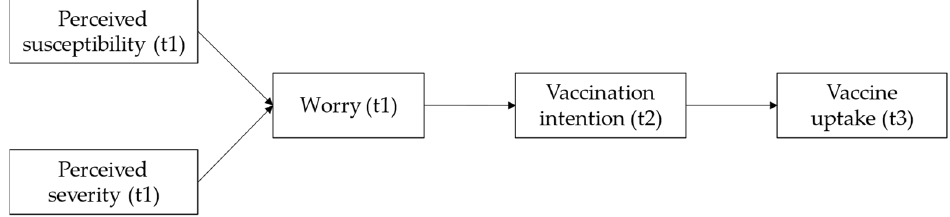
Figure 1. Graphic representation of the proposed mediating processes predicting COVID-19 vaccine uptake.